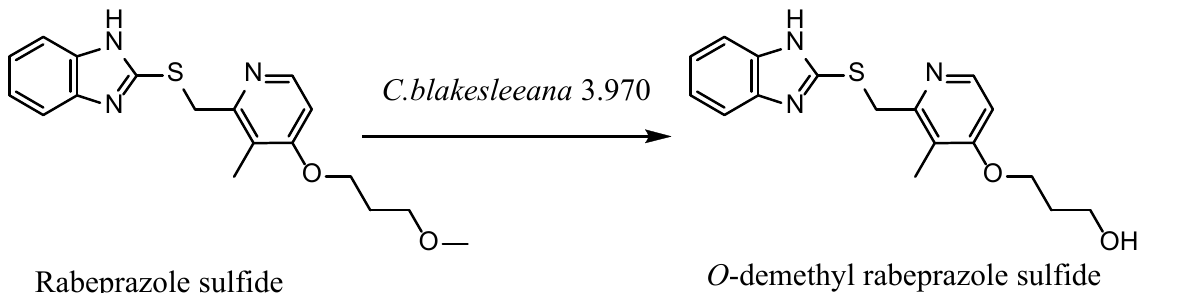
Figure 1. Rabeprazole sulfide and its O -demethyl metabolite obtained by the biotransformation of Cunninghamella blakesleeana 3.970.